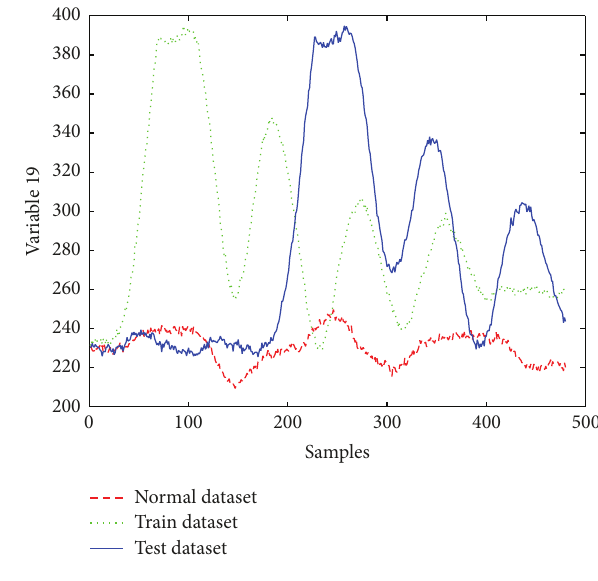
Figure 3: TE: plot of variable 19 in fault 1.